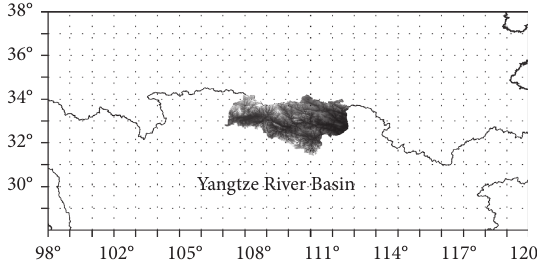
Figure 2: Grid points used from the GCM-simulated precipitation data.